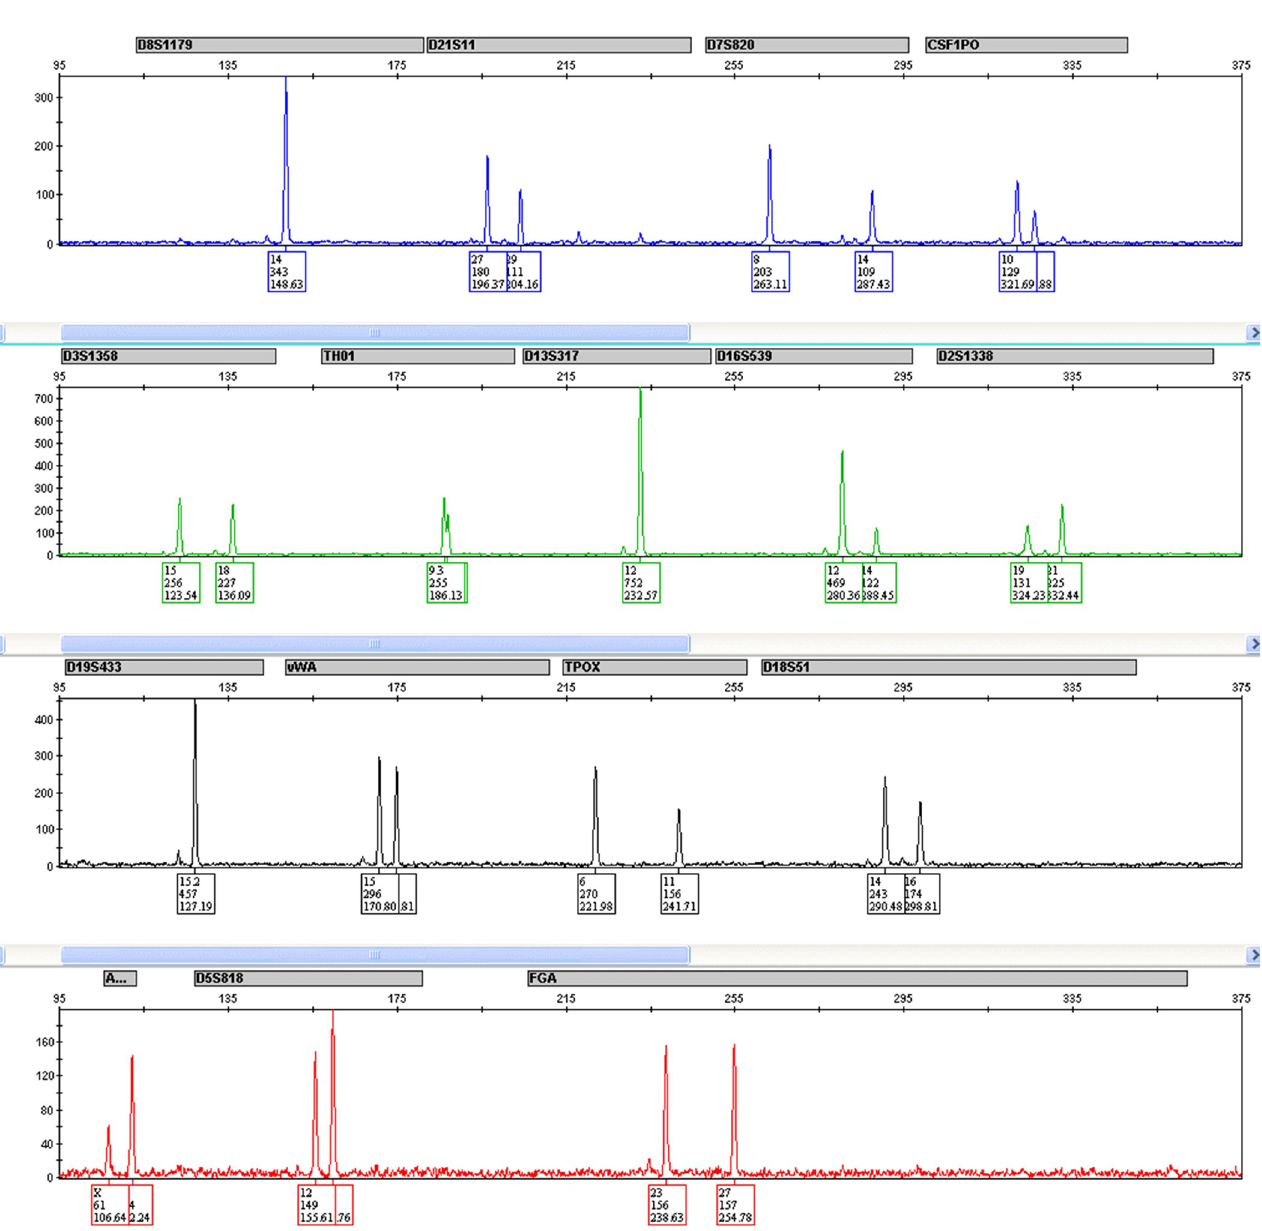
Fig 4. Representative electropherogram of 56 sperm cells tweezed from the mock sexual assault sample. All observed alleles are concordant with the sperm cell donor.